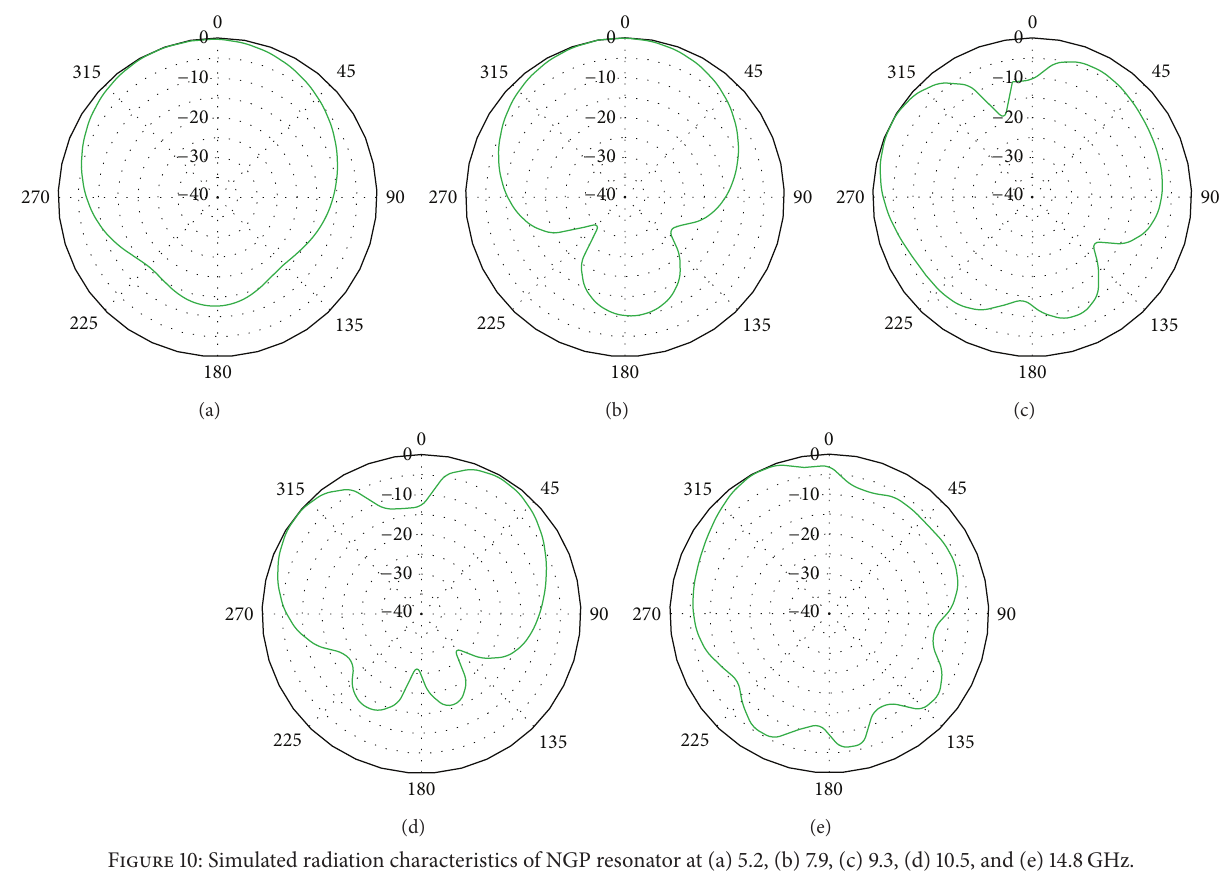
Figure 10: Simulated radiation characteristics of NGP resonator at (a) 5.2, (b) 7.9, (c) 9.3, (d) 10.5, and (e) 14.8 GHz.